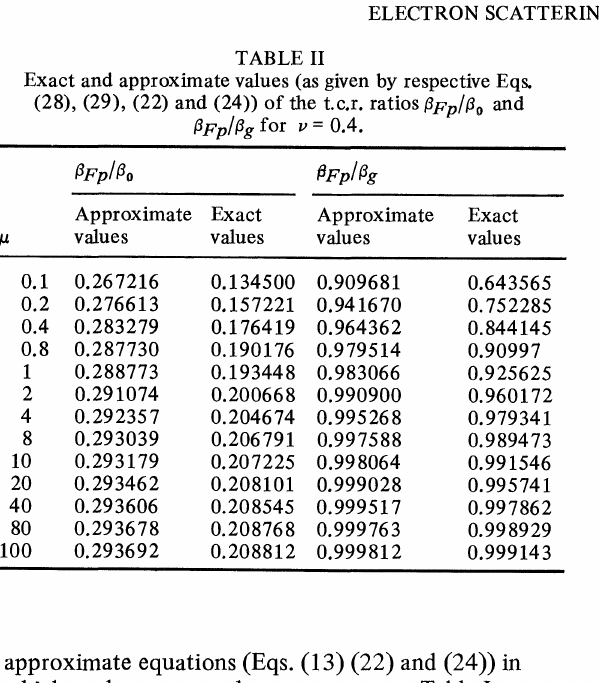
TABLE II Exact and approximate values (as given by respective